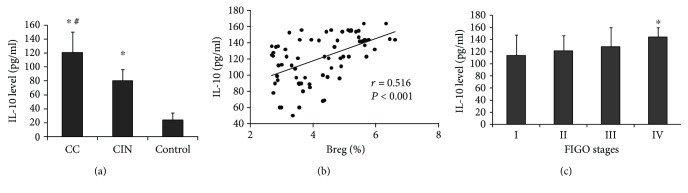
The IL-10 level in three groups and in different FIGO stages of cervical cancer patients. IL-10 level was detected with ELISA. (a) Serum IL-10 levels in three groups. ∗P < 0.05 compared with the control group; #P < 0.05 compared with the CIN group. (b) Breg was positively correlated with IL-10 (R = 0.516, P < 0.001). (c) Serum IL-10 levels in different FIGO stages of cervical cancer patients. ∗P < 0.05 compared with stage I.